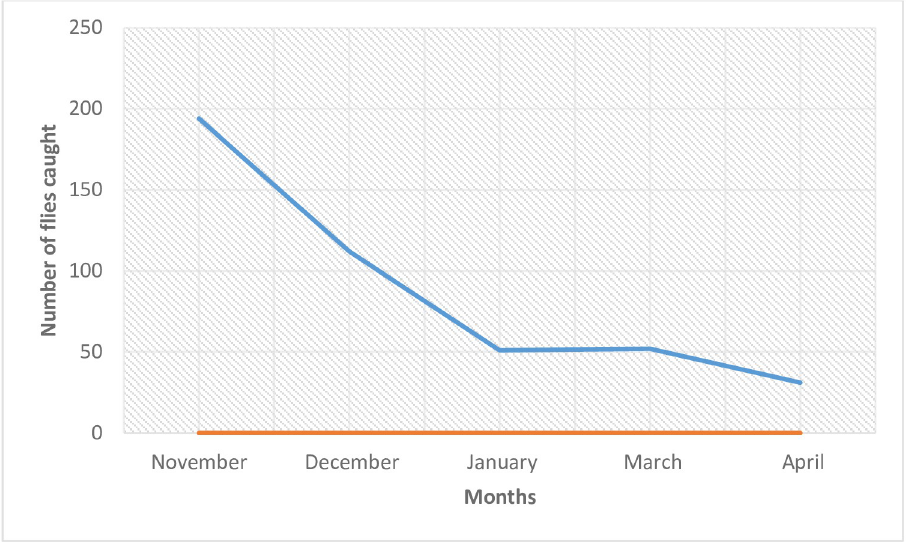
Fig 1. Monthly distribution of S . damnosum in the study